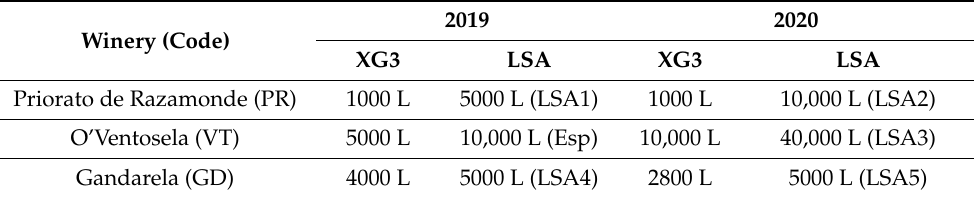
Table 1. Fermentation trials: Volume and yeast strains used to inoculate Treixadura musts in each winery and vintage.